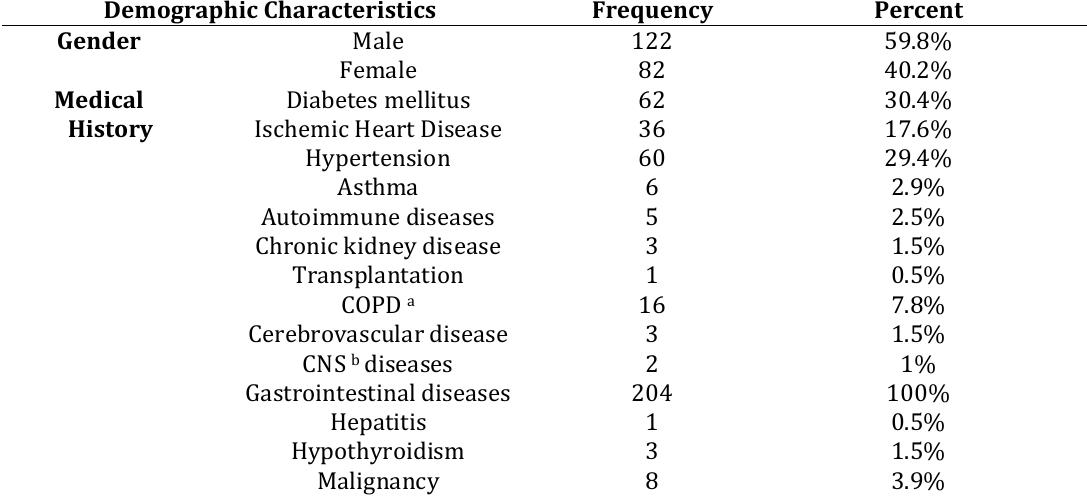
Table1. Demographic Characteristics of COVID-19